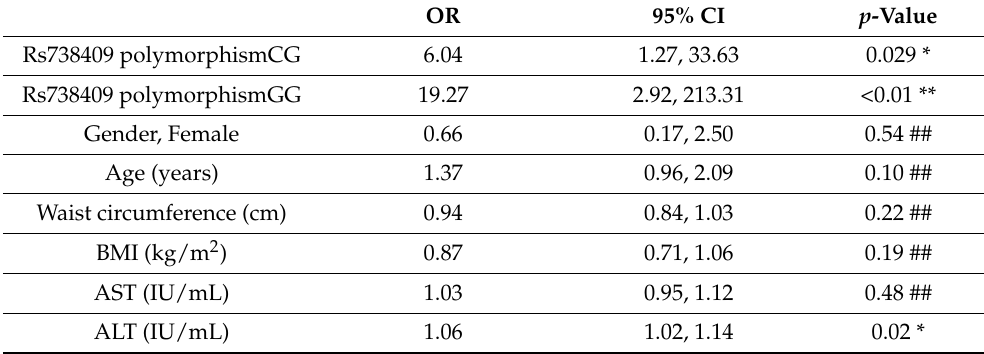
Table 5. Adjusted multivariate logistic regression: polymorphism on